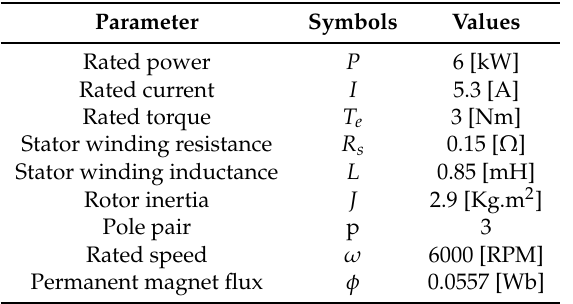
Table 2. Specifications of permanent magnet synchronous motor (PMSM).